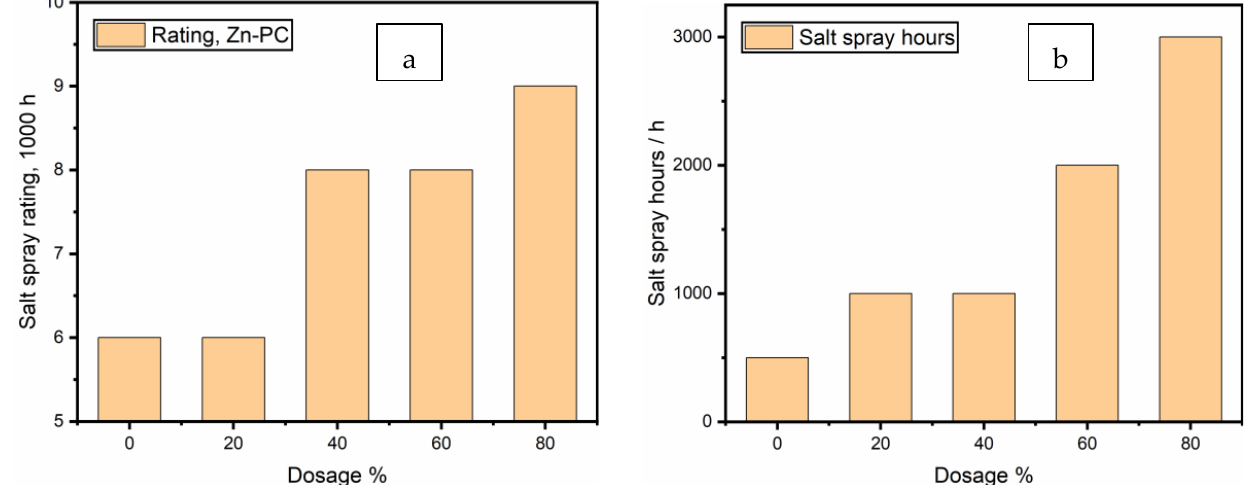
Figure 10. Neutral salt-spray results. ( a ) ratings after 1000 h, ( b ) neutral salt-spray hours to reach a mean creepage of 2 mm.